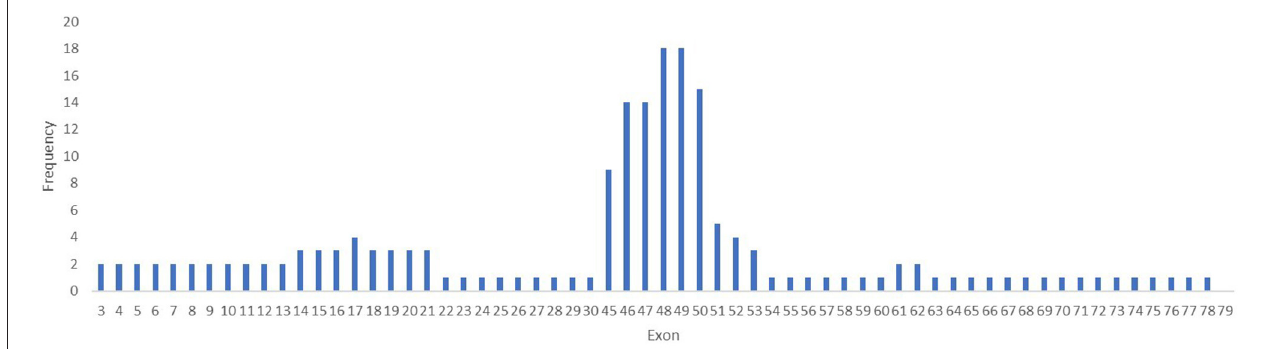
FIGURE 4 | Frequency of mutation per exons in the DMD gene. The exons 48 and 49 are the most involved in mutations in the DMD gene in our study